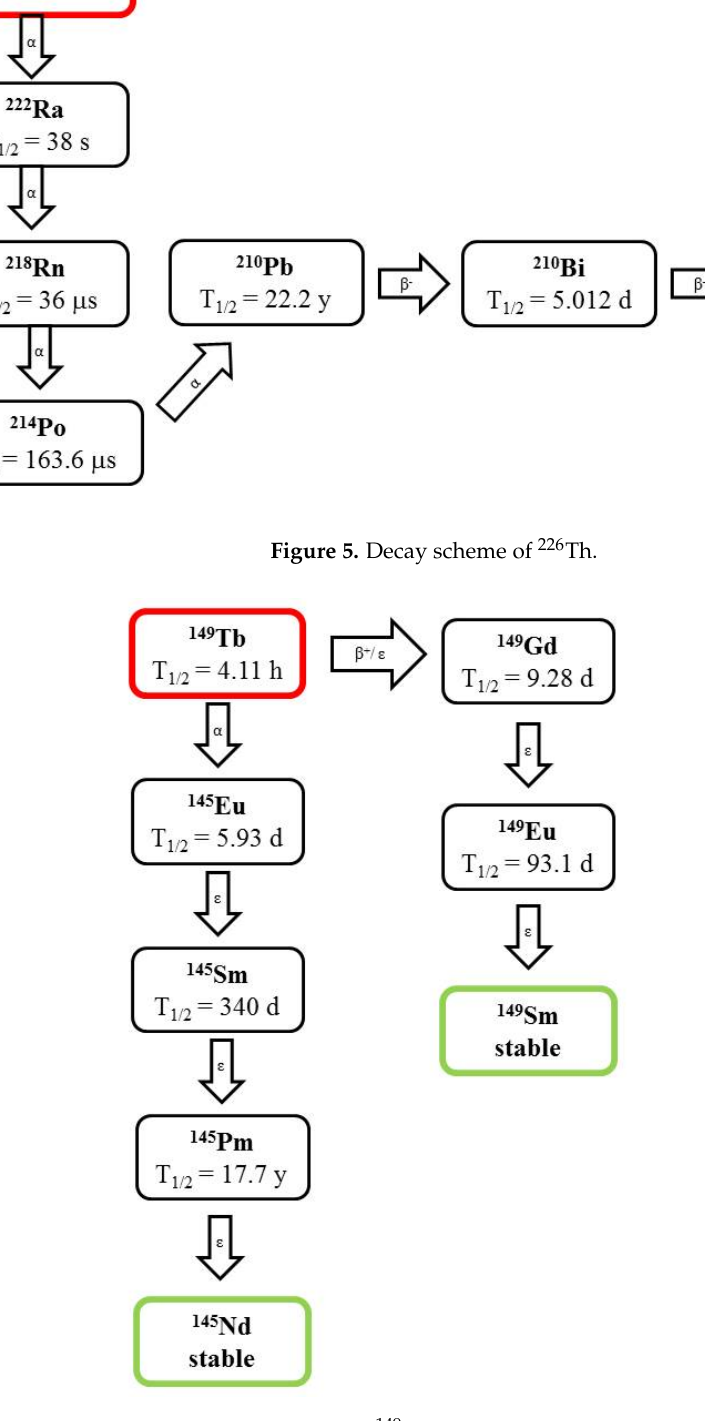
Figure 6. Decay scheme of 149 Tb.